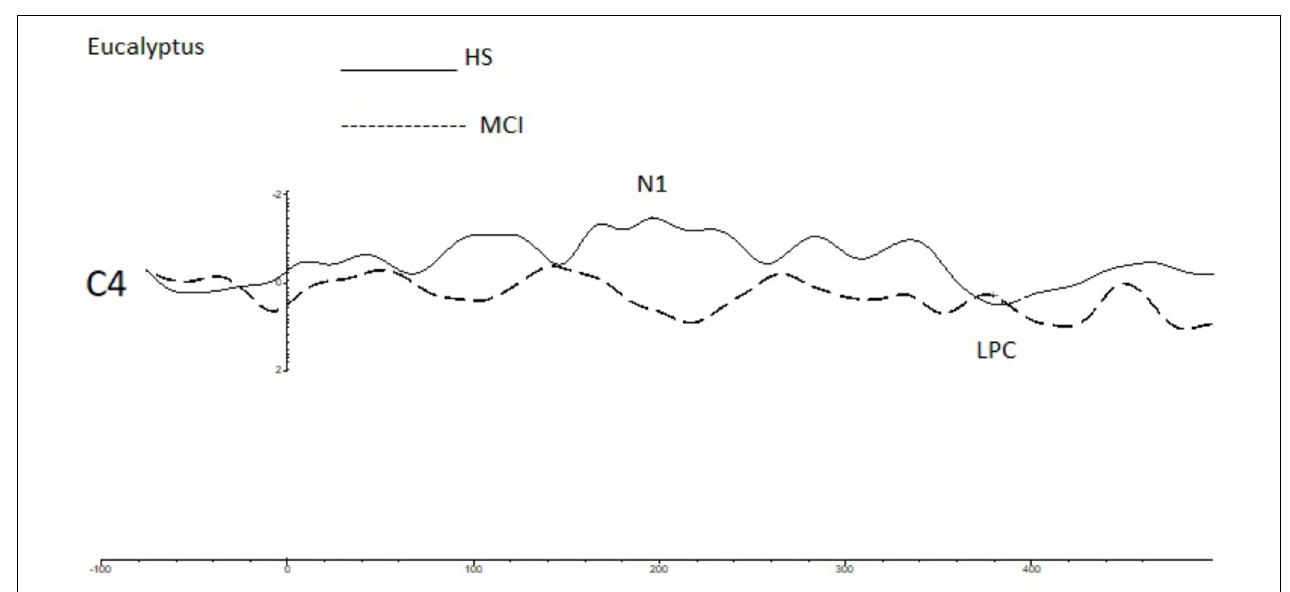
FIGURE 3 | A comparison of the grand averages of OERP waveforms (recorded at the C4 electrode) elicited by the rose eucalyptus for the MCI (dashed line) and HS (continuous line) groups. The N1 and LPC components are